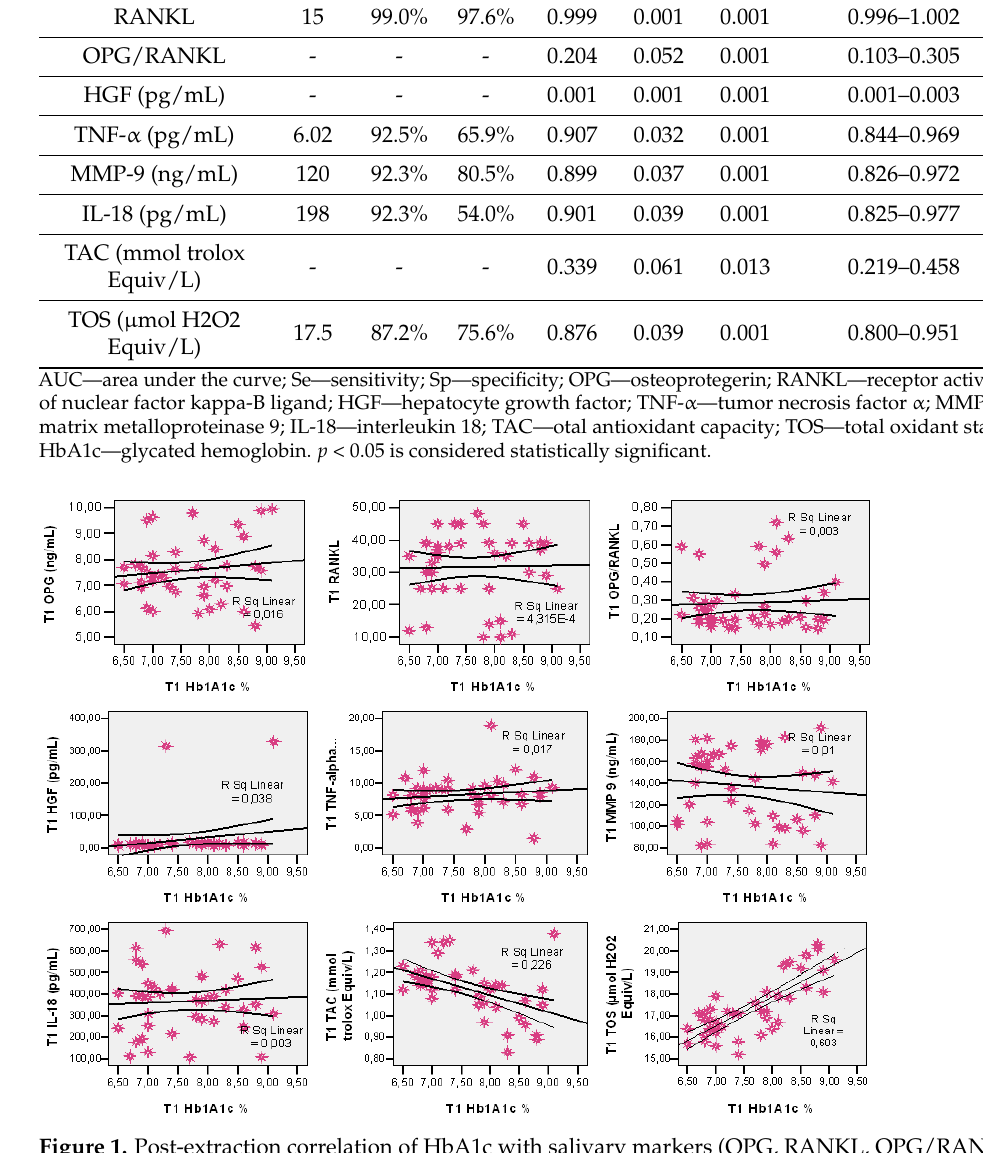
Figure 1. Post-extraction correlation of HbA1c with salivary markers (OPG, RANKL, OPG/RANKL, HGF, TNF- α , MMP-9, IL-18, TOS and TAC). We used multivariate analysis to quantify the intensity and direction of influence of the correlation between the analyzed factors (Figure 2). Multiple linear regression establishes the predictive efficiency of detected salivary markers (independent variables) on the HbA1c dependent variable